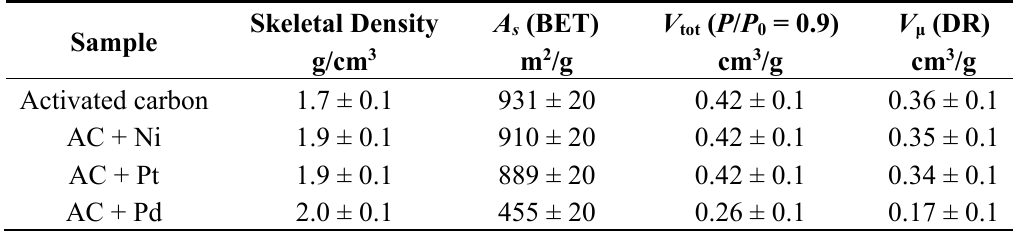
Figure 6. Nitrogen adsorption isotherms at 77 K of pristine and Ni-, Pd- and Pt-anchored activated carbon. Table 1. Textural properties of pristine and Ni-, Pt-, Pd-anchored activated